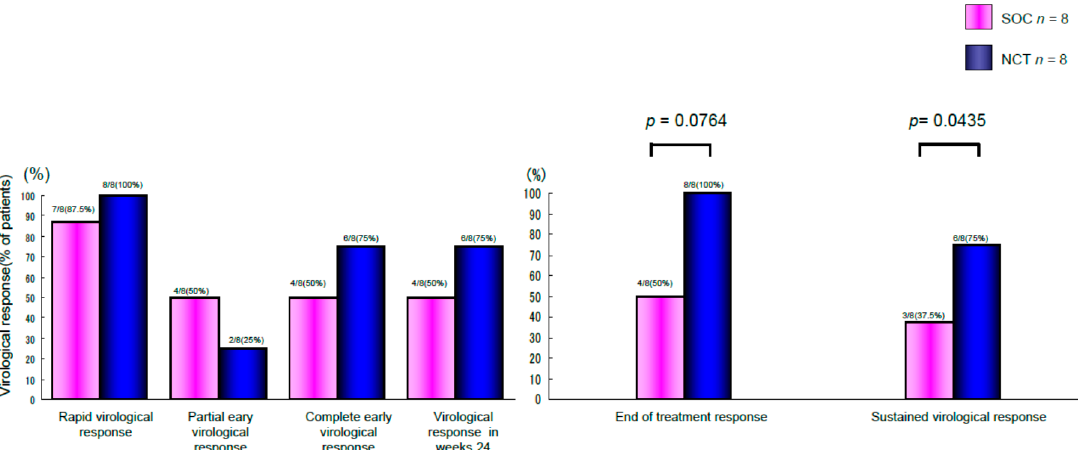
Figure 2. Rates of early virologic responses in the 4, 12 and 24 weeks (left panel), and end-of–treatment virologic response and sustained virologic response (right panel) in chronic hepatitis C patients with genotype 1b and high viral loads treated with the NCT or the SOC according to intention-to-treatment. NCT: novel combination treatment (NCT) consists of induction therapy with natural IFN-beta followed by the SOC. SOC: standard of care (SOC) consists of PegIFN-alpha 2b plus RBV.